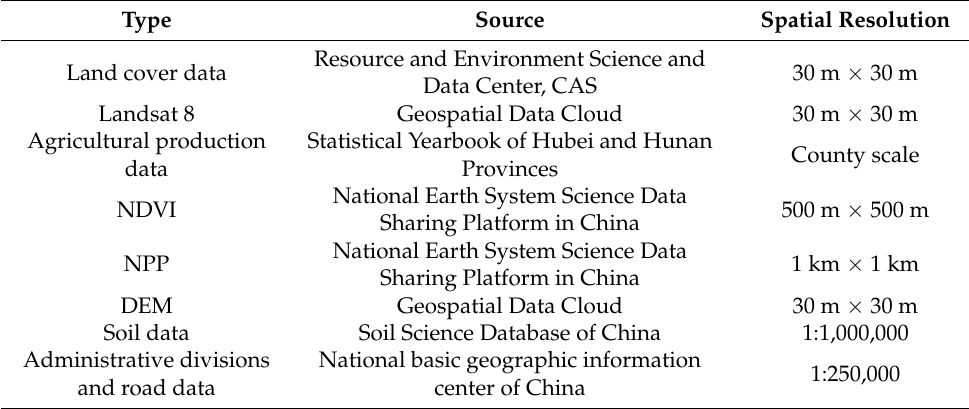
Table 3. Type, sources and spatial resolution of data used in this study. Type Source Spatial Resolution Resource and Environment Science and Land cover data Agricultural production